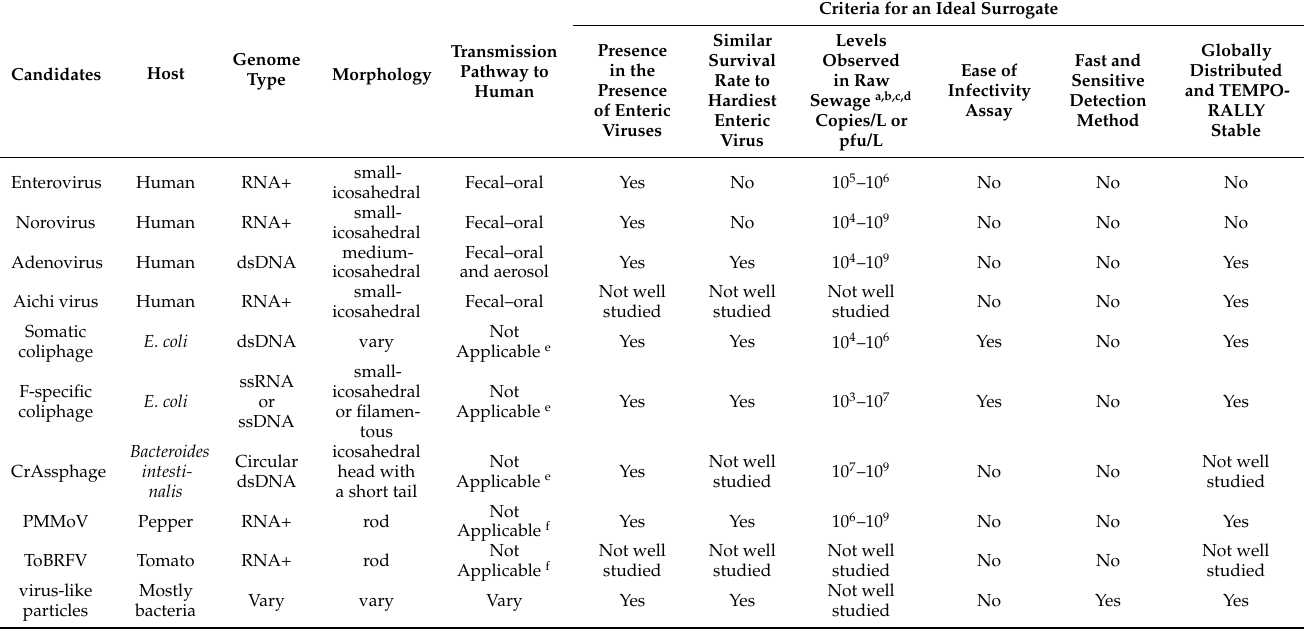
Table 2. Potential Human Viral Pathogens and Surrogates to Indicate Human Health Risks During Non-Potable Water